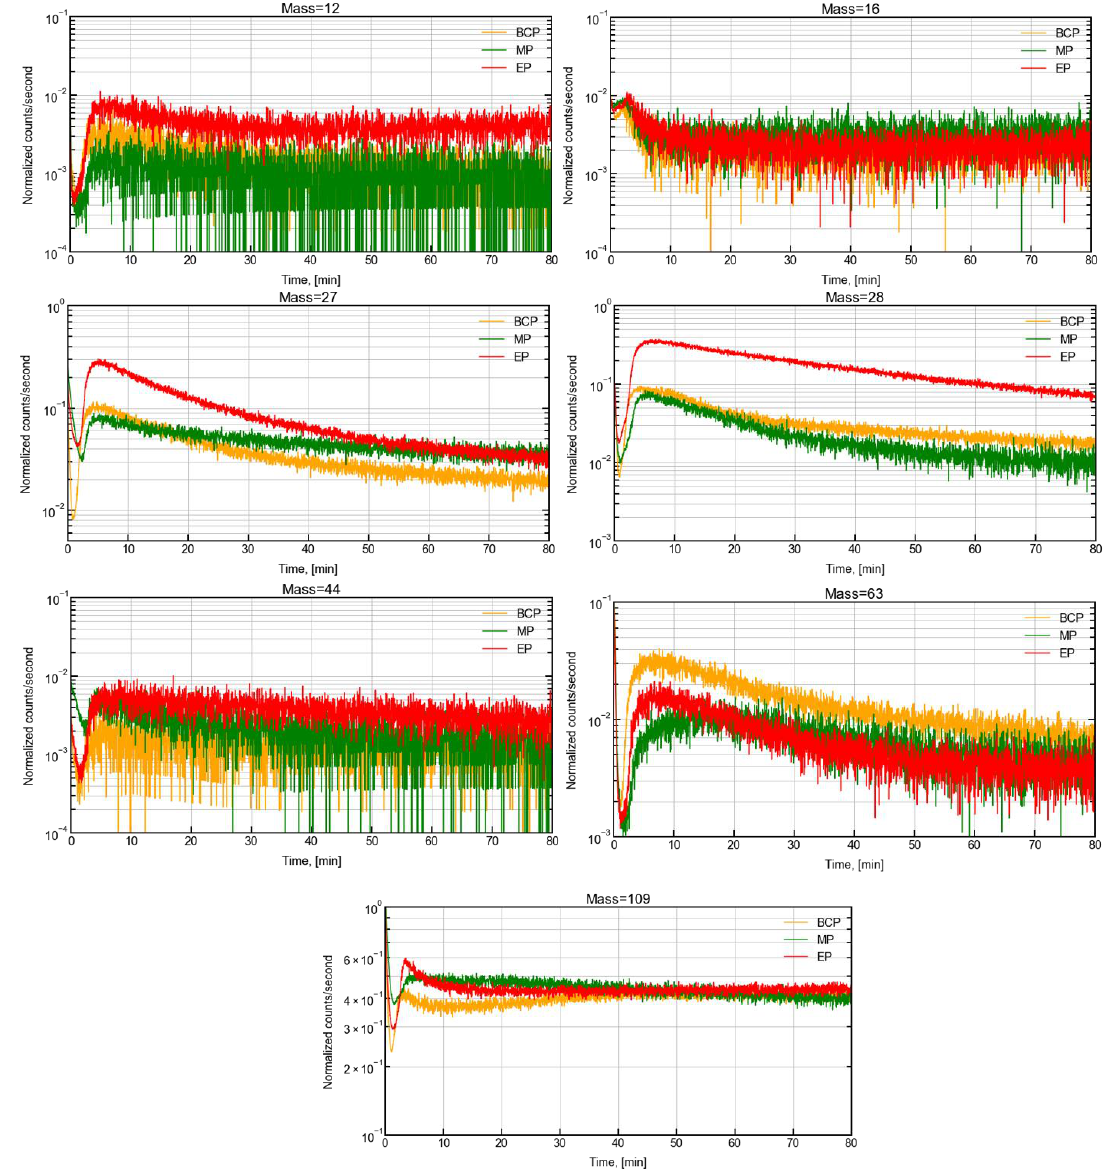
Figure A1. SIMS comparison of depth profiles after metallographic polishing (MP), buffered chemical polishing (BCP), and EP (electro-polishing) measured for desired investigated mass.